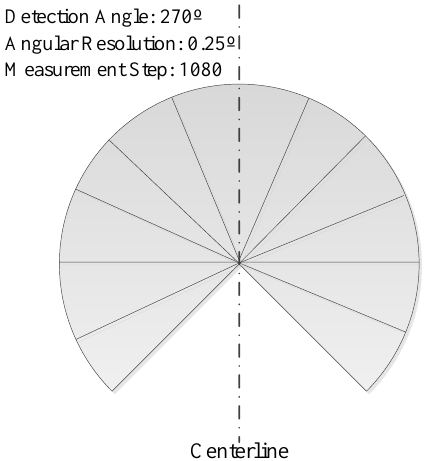
Figure 2. Detection range of the 2D LIDAR expresses a sector spanning 270° with 0.25° angular resolution. The detecting plane of the LIDAR that is assembled vertically result from such structure.